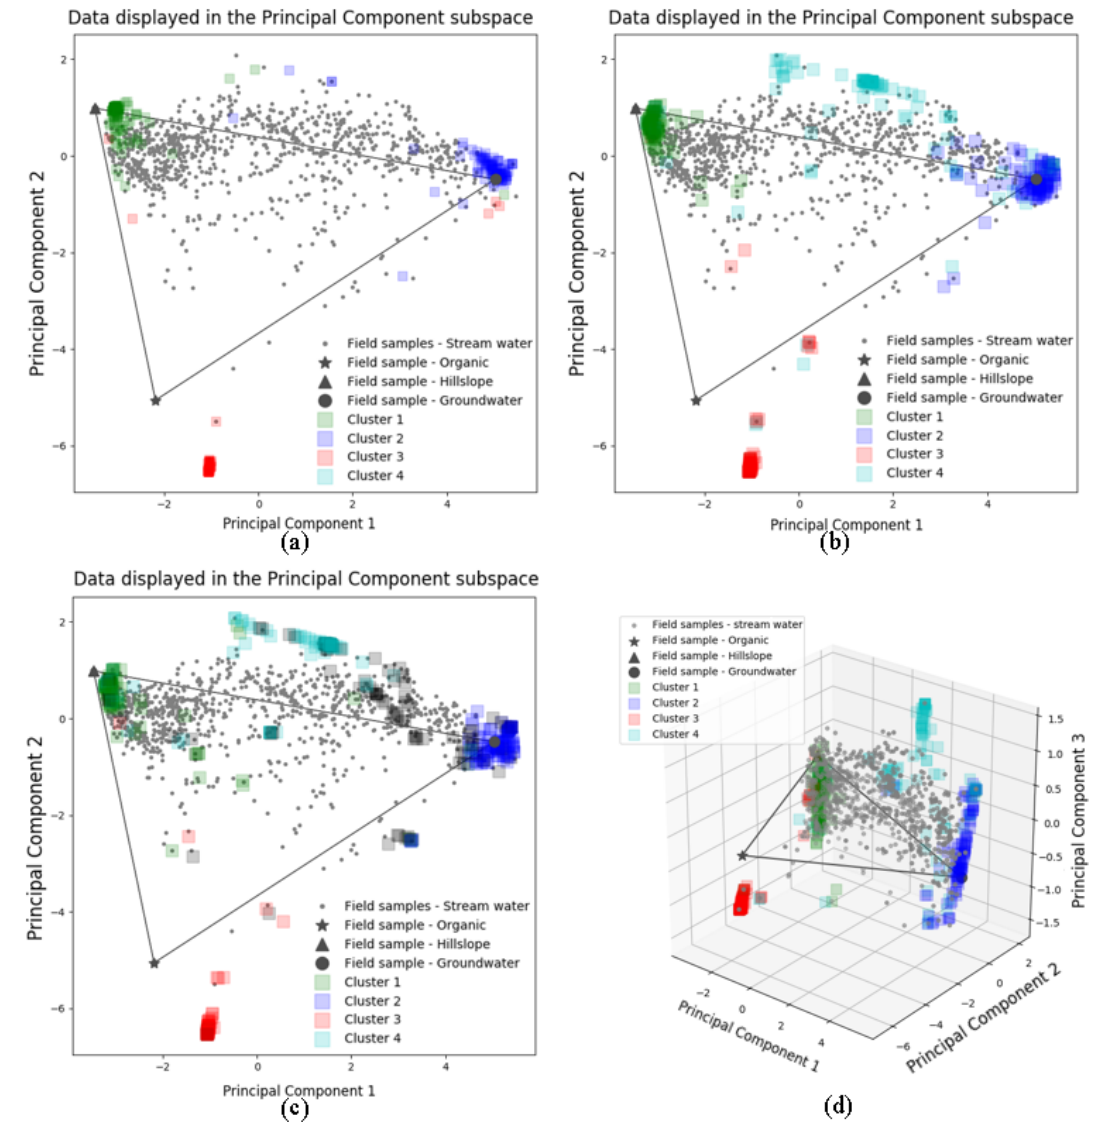
Figure 3. The 100 random initialized CH-NMF run results for three (a) , four (b, d) , and five (c) end-member cases. Panels (a) – (c) are in the 2D PC2 vs. PC1 subspaces. Panel (d) is in the 3D PC3 vs. PC2 vs. PC1 subspace. The color shade of each cluster reflects the concentration of the vertices at its